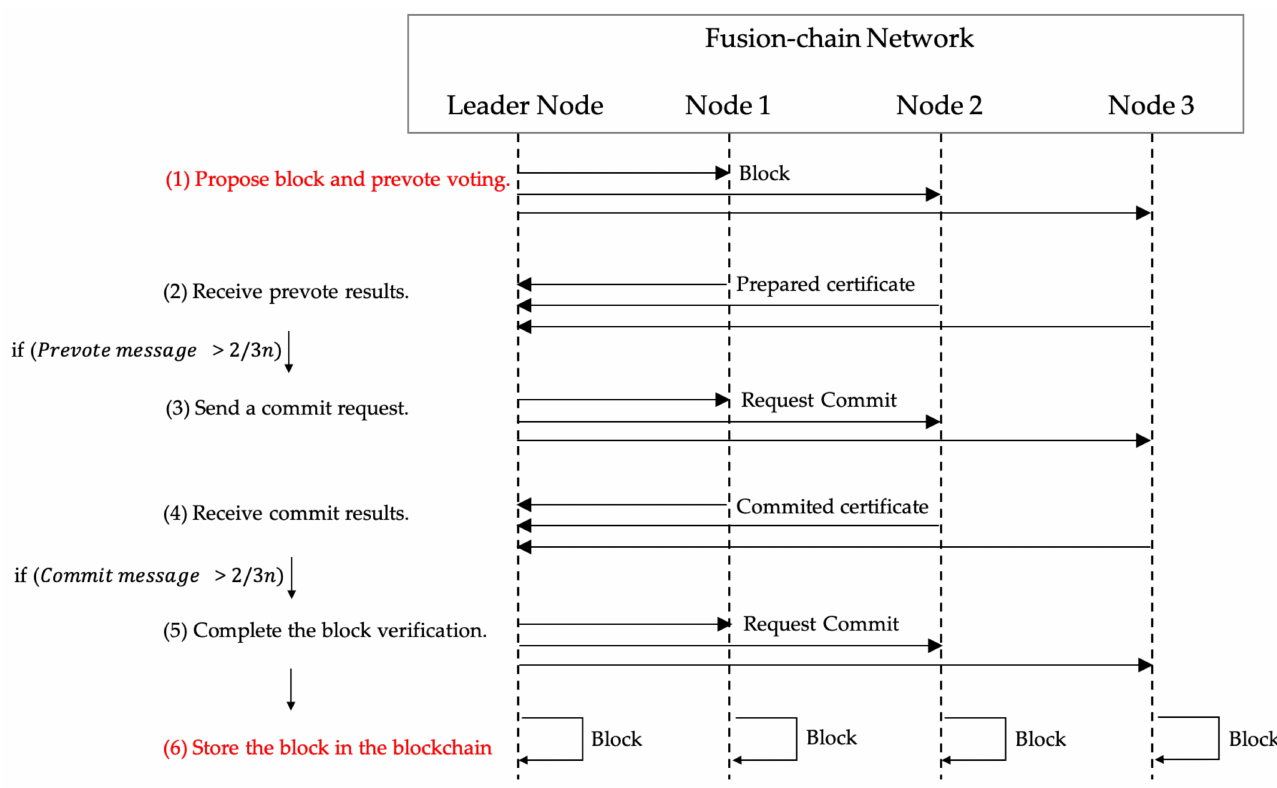
Figure 2. A sequence diagram Fusion Chain with